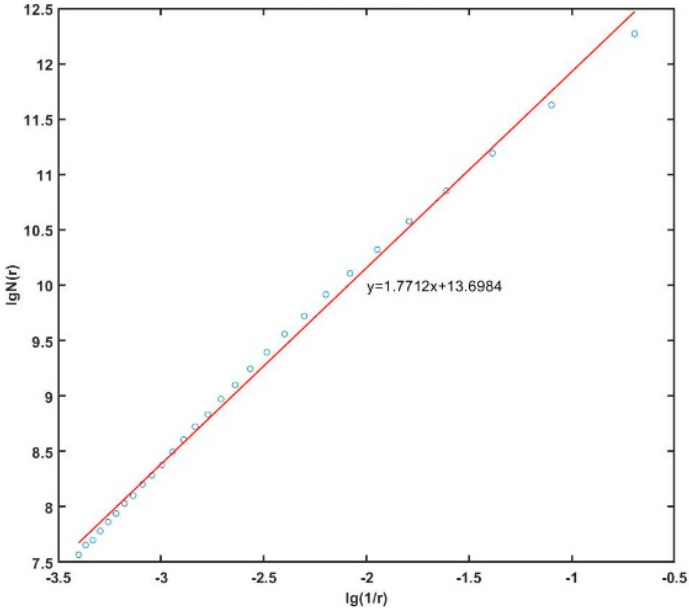
Figure 15. The fractal-dimension fitting curve of the unburned concrete sample. Table 3. The fractal dimensions of all unburned concrete